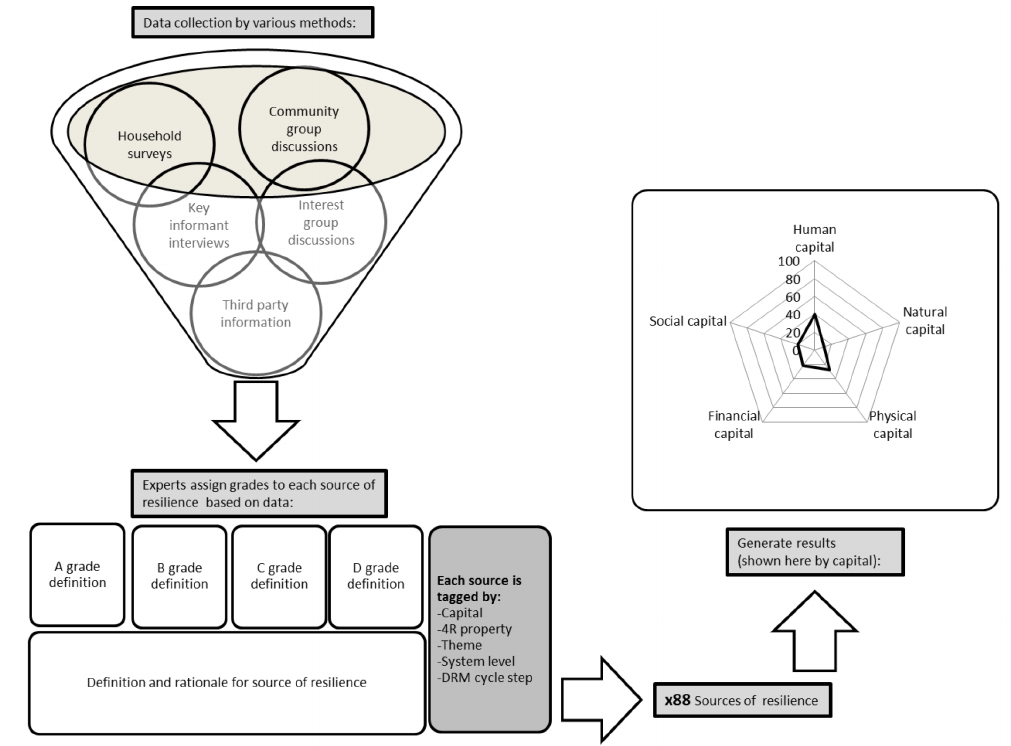
Figure 3. Zurich Flood Resilience Measurement Framework implementation process.